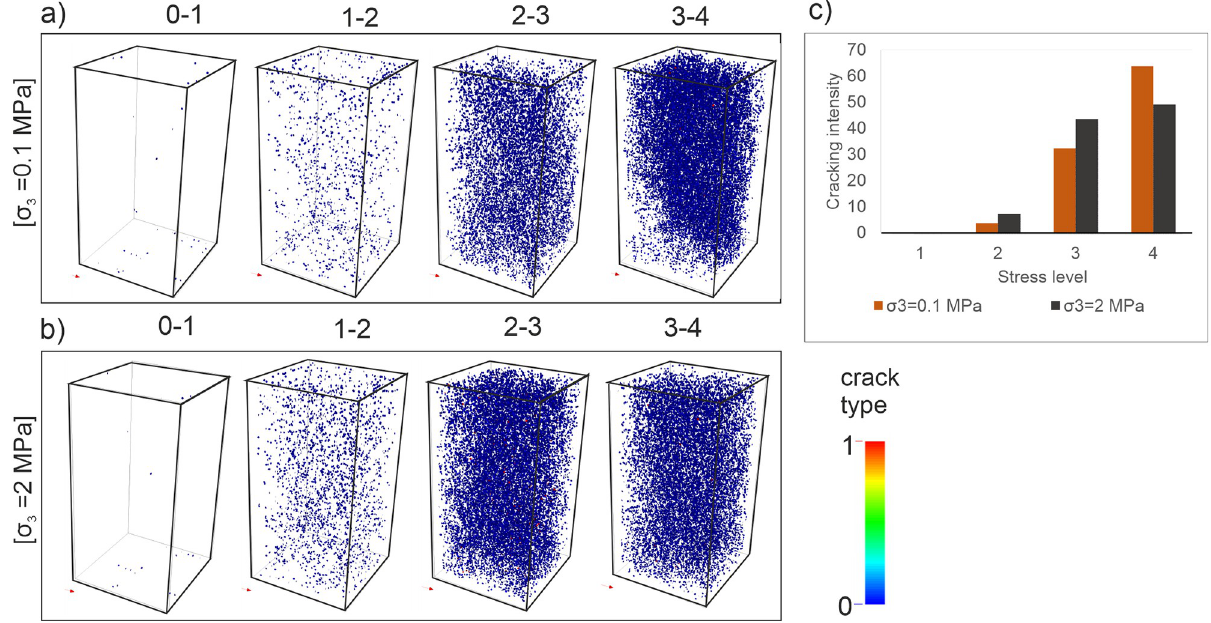
Fig 6. Spatial distribution of microcracks during the compressive test simulations. (a) σ stress levels (plotted in Fig 5).